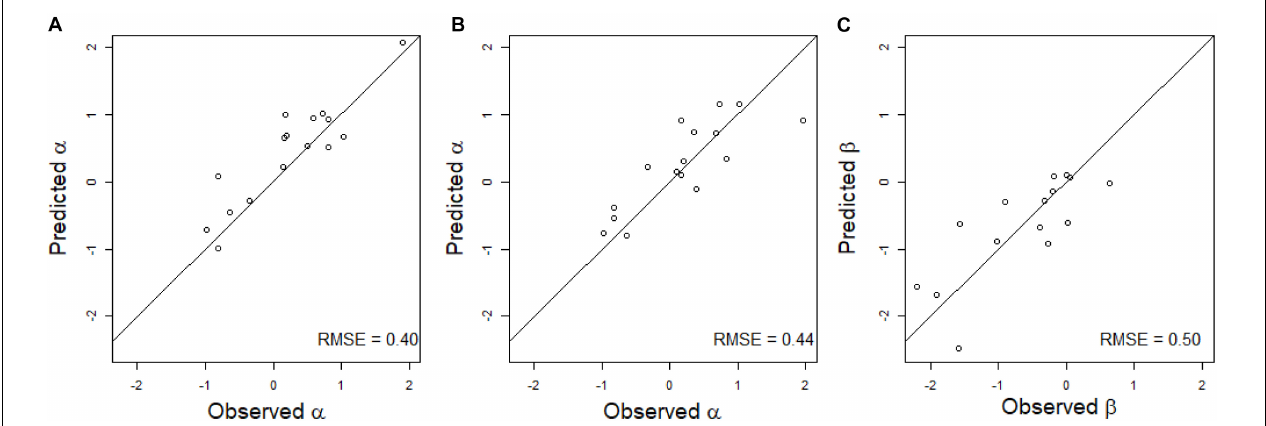
FIGURE 3 | Scatter plot of the predicted and observed values of the regression coefficient of a linear regression (A) or of a quadratic regression (B,C) of GY on HD in scenario CVnewE. Observed α and β correspond to the estimates obtained from the linear (A) and quadratic (B,C) regressions of GY on HD in each environment. Predicted α and β correspond to the prediction of the α (A) or α and β (B,C) of the predicted environment (leave-one-environment-out scheme), using a multiple linear regression of the α (A) or α and β (B,C) estimated in the calibration environments on the environmental covariates. The black line corresponds to the line y = x .